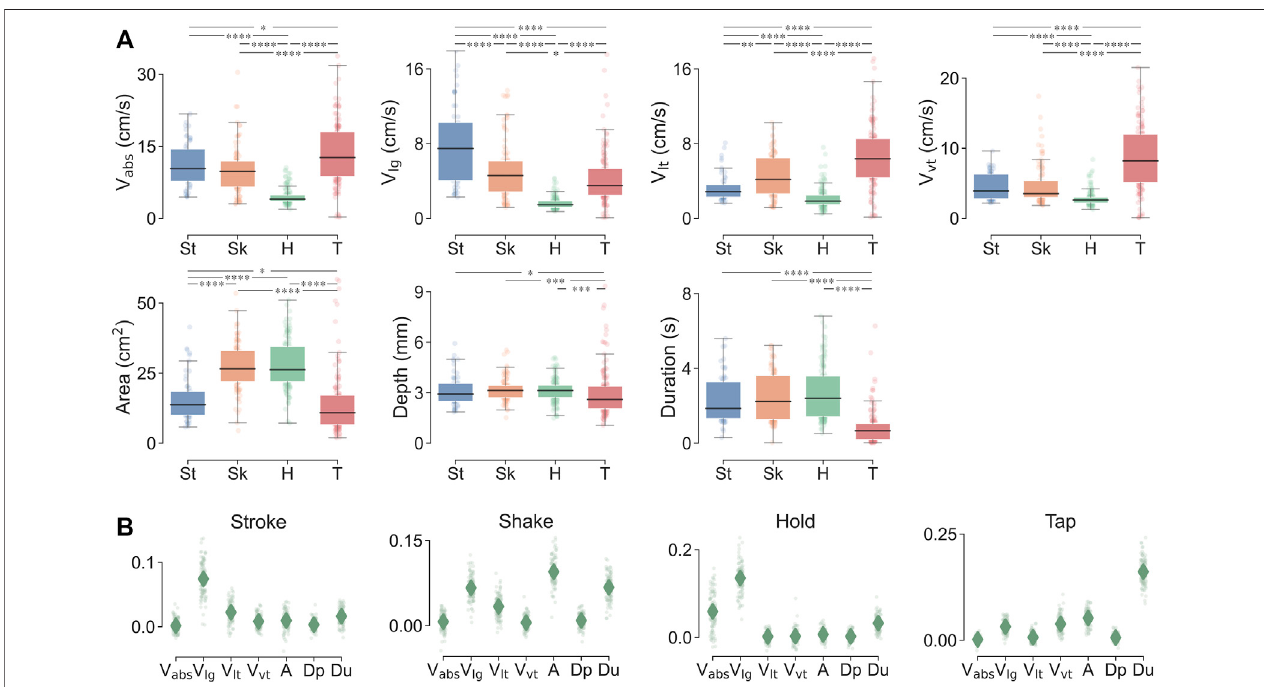
FIGURE4|(A) Comparison ofcontactattributesacrossthefourtouchgestures.* p < 0.05,** p < 0.01,*** p < 0.001,**** p < 0.0001werederivedbypaired-sample Mann – WhitneyUtests. (B) Importanceofcertaincontactattributesinidentifyingeachtouchgestureusingrandomforestclassi fi cation.Diamondsdenotemeans;points denote importance values of 100 repetitions of classi fi